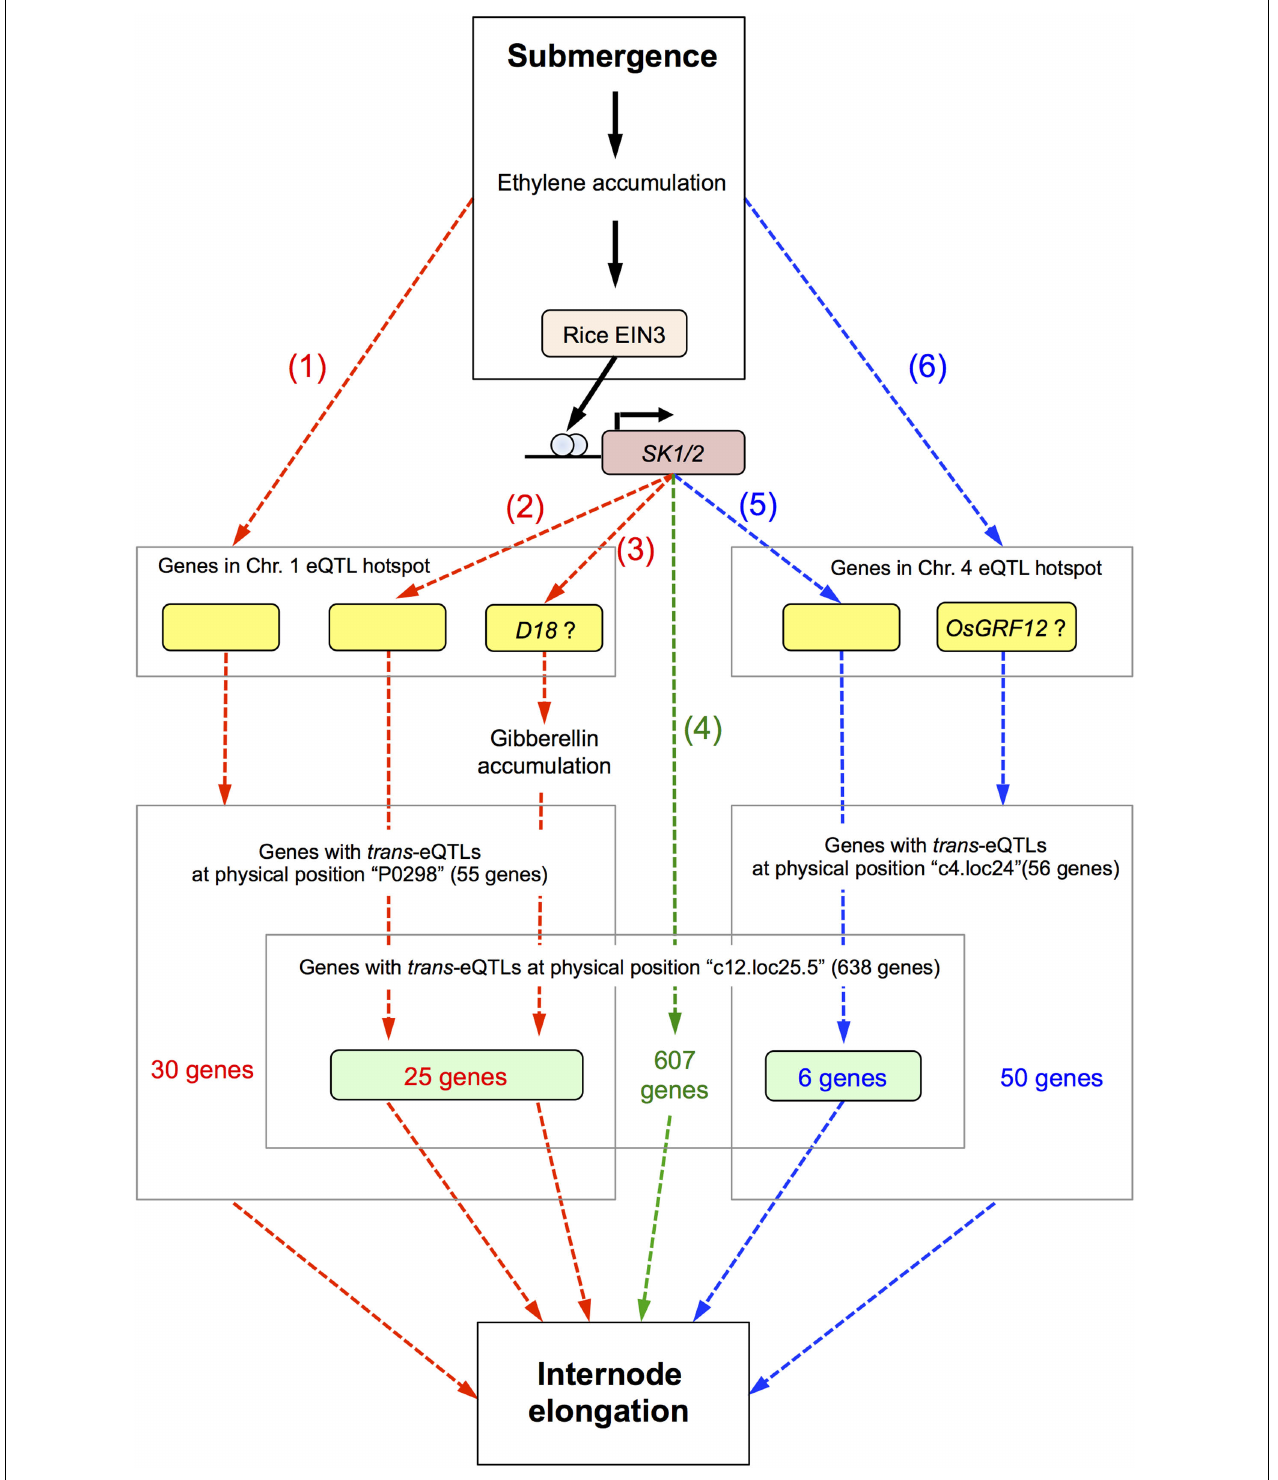
FIGURE 7 | Hypothetical model of signaling for internode elongation in submerged deepwater rice. Bold black arrows represent known pathways and dashed arrows the hypothetical pathways described in this study. Red and blue dashed arrows indicate the pathways regulated by genes in the eQTL hotspot on chromosome 1 and 4, respectively. Green dashed arrows indicate the pathway regulated by SK1/2 independent of the eQTL hotspots on chromosomes 1 and 4. Details are described in the “Discussion.”